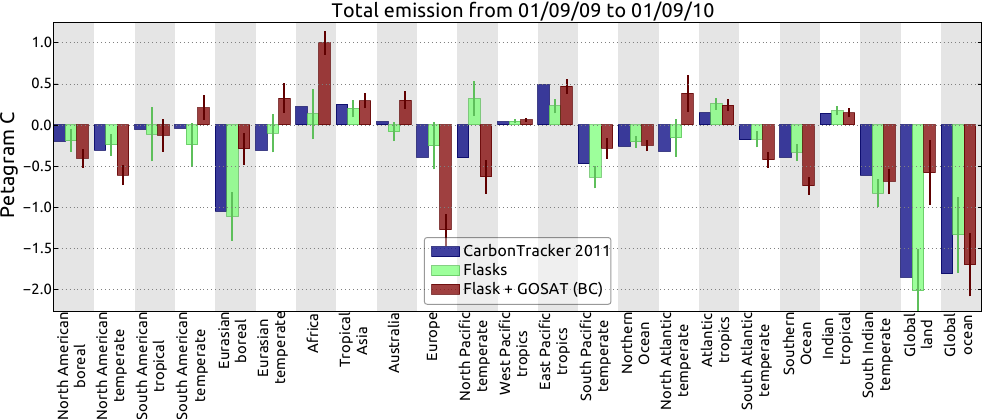
Fig. 15. Comparison of our optimized fluxes with those from CarbonTracker 2011 over the TRANSCOM regions and the global land and ocean. All fluxes are without fossil fuel emissions. Since TRANSCOM regions include northern and southern Africa, whereas we aggregate over Saharan and sub-Saharan Africa (Fig. 7), in this figure we have presented the flux total over Africa.